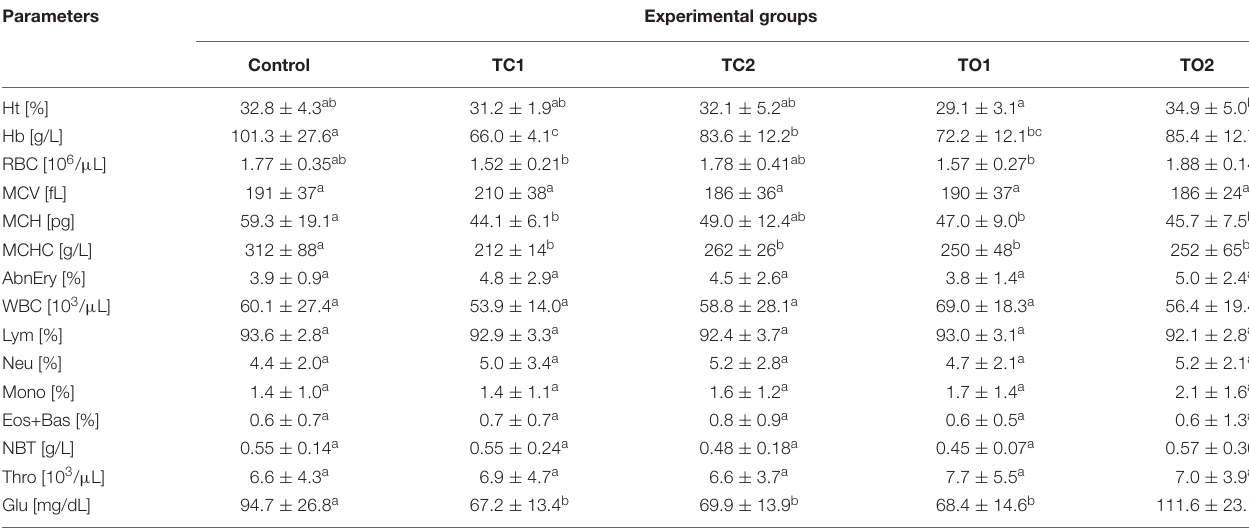
TABLE 1 | Hematological parameters in common carp after oral application of phytochemicals. Parameters Experimental